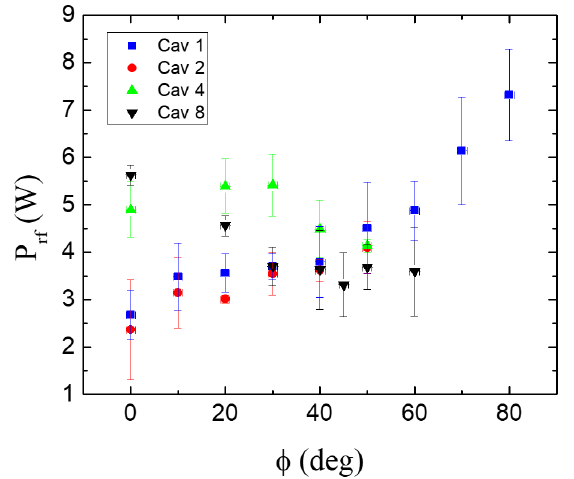
FIG. 14. The rf heat load at 2.07 K and 7 MV = m measured as a function of the detuning angle for four cavities in C50 CM 1L13. Cavities 1 and 2 are C75 prototype cavities.